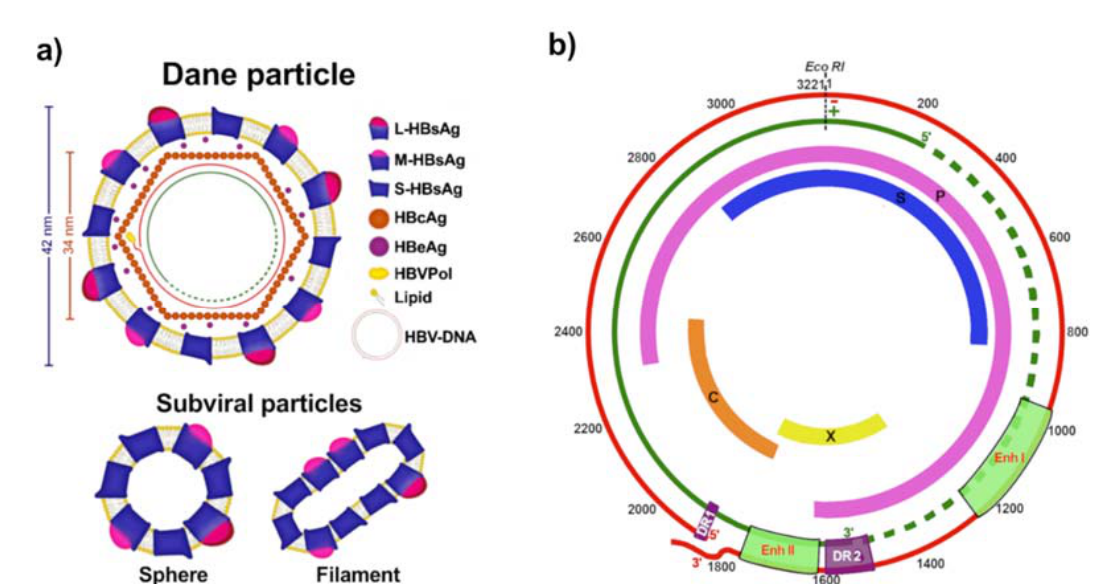
Figure 1. HBV ( a ) particle structures and ( b ) genome and ORFs. In red and green, the negative and positive strands (re-